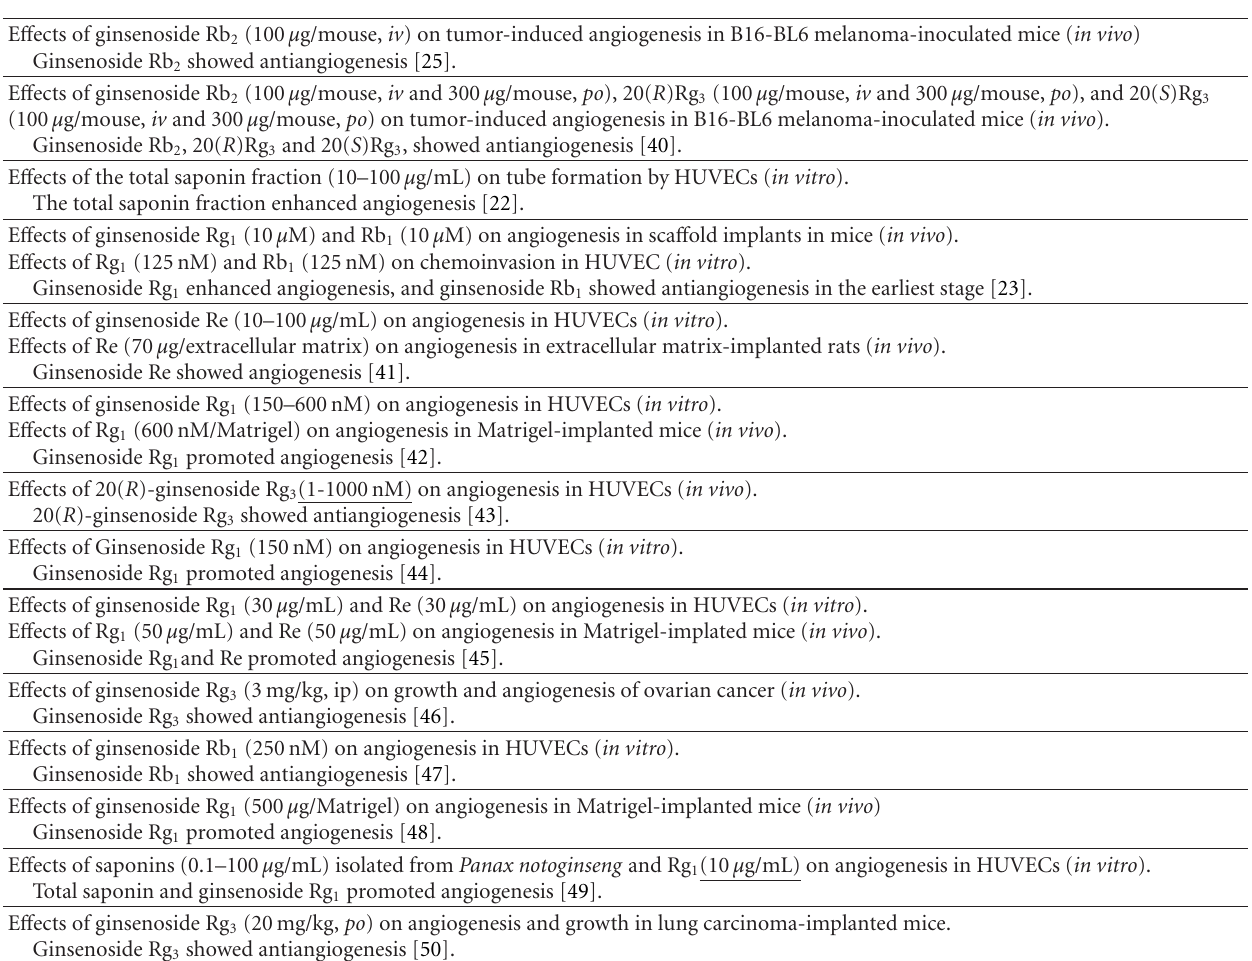
Table 1: E ff ects of various ginseng saponins on